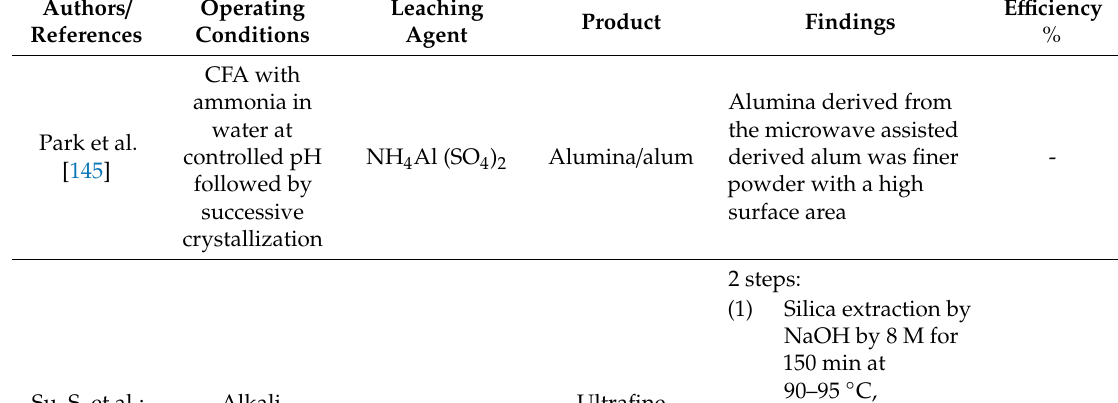
Table 3. Acid-based dissolution of Alumina from fly